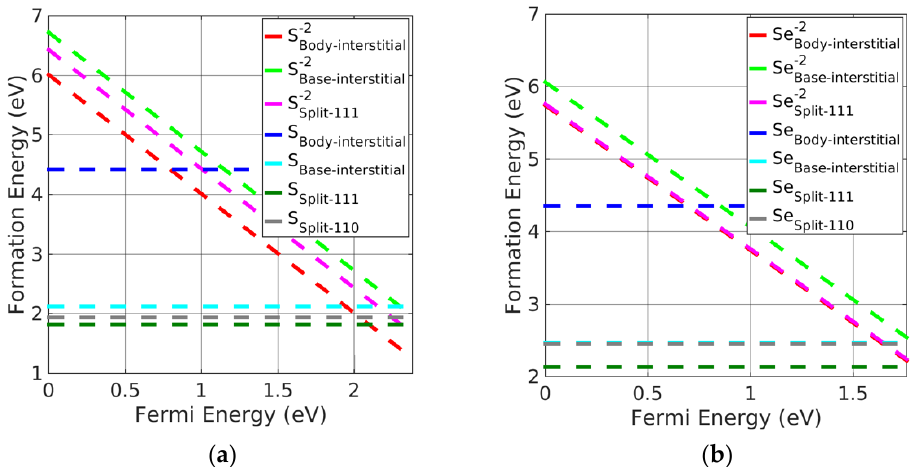
Figure 5. Formation energy of charged interstitial defects in ( a ) CaS at S − rich and ( b ) MgSe at Se − rich conditions.